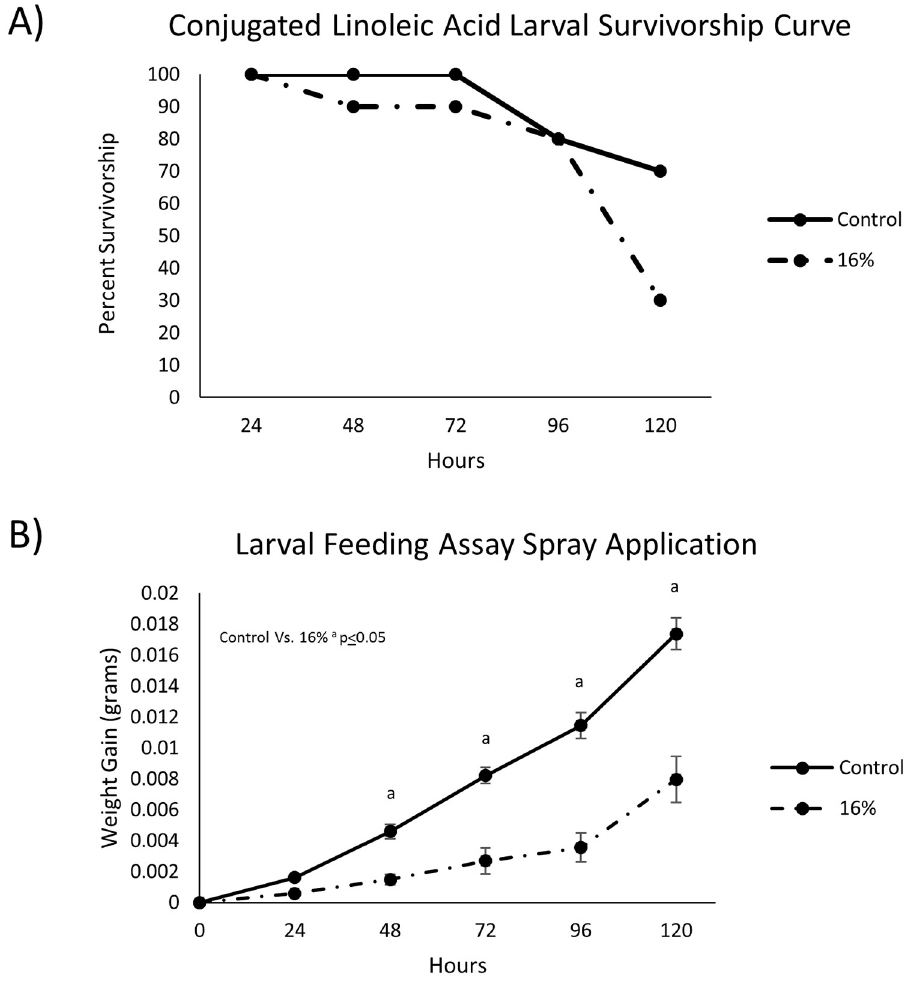
Fig 3. (A) Survivorship curves of 2 nd instar L . decemlineata larvae after being fed a continual diet of 16% CLA foliage, treated using a controlled 20-gal/acre application volume. (B) 2 nd instar L . decemlineata larvae weight gain illustrating a statistically significant decrease in weight gain over 120 hours compared to control (data represents mean weight gain ± S.E.).